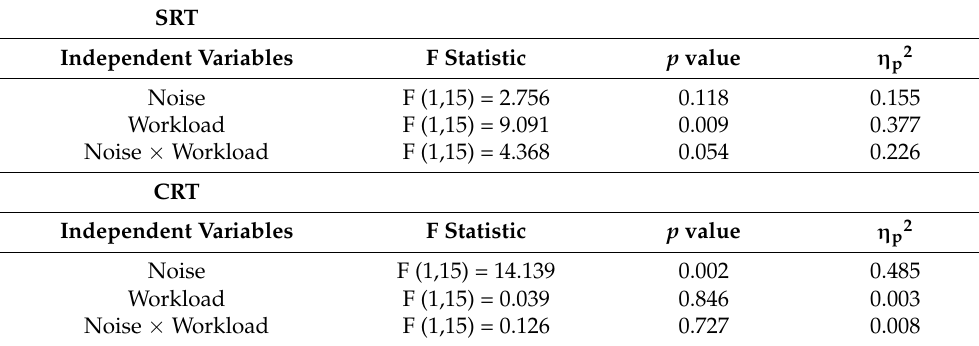
Figure 5. Response times (ms) during a choice response time (CRT) task, without (No Noise) and with noise (Noise), before (PRE) and after (POST) the workload. * represents significant difference at p < 0.05, and bars represent standard errors. Table 2. Noise × Workload Repeated Measures ANOVA